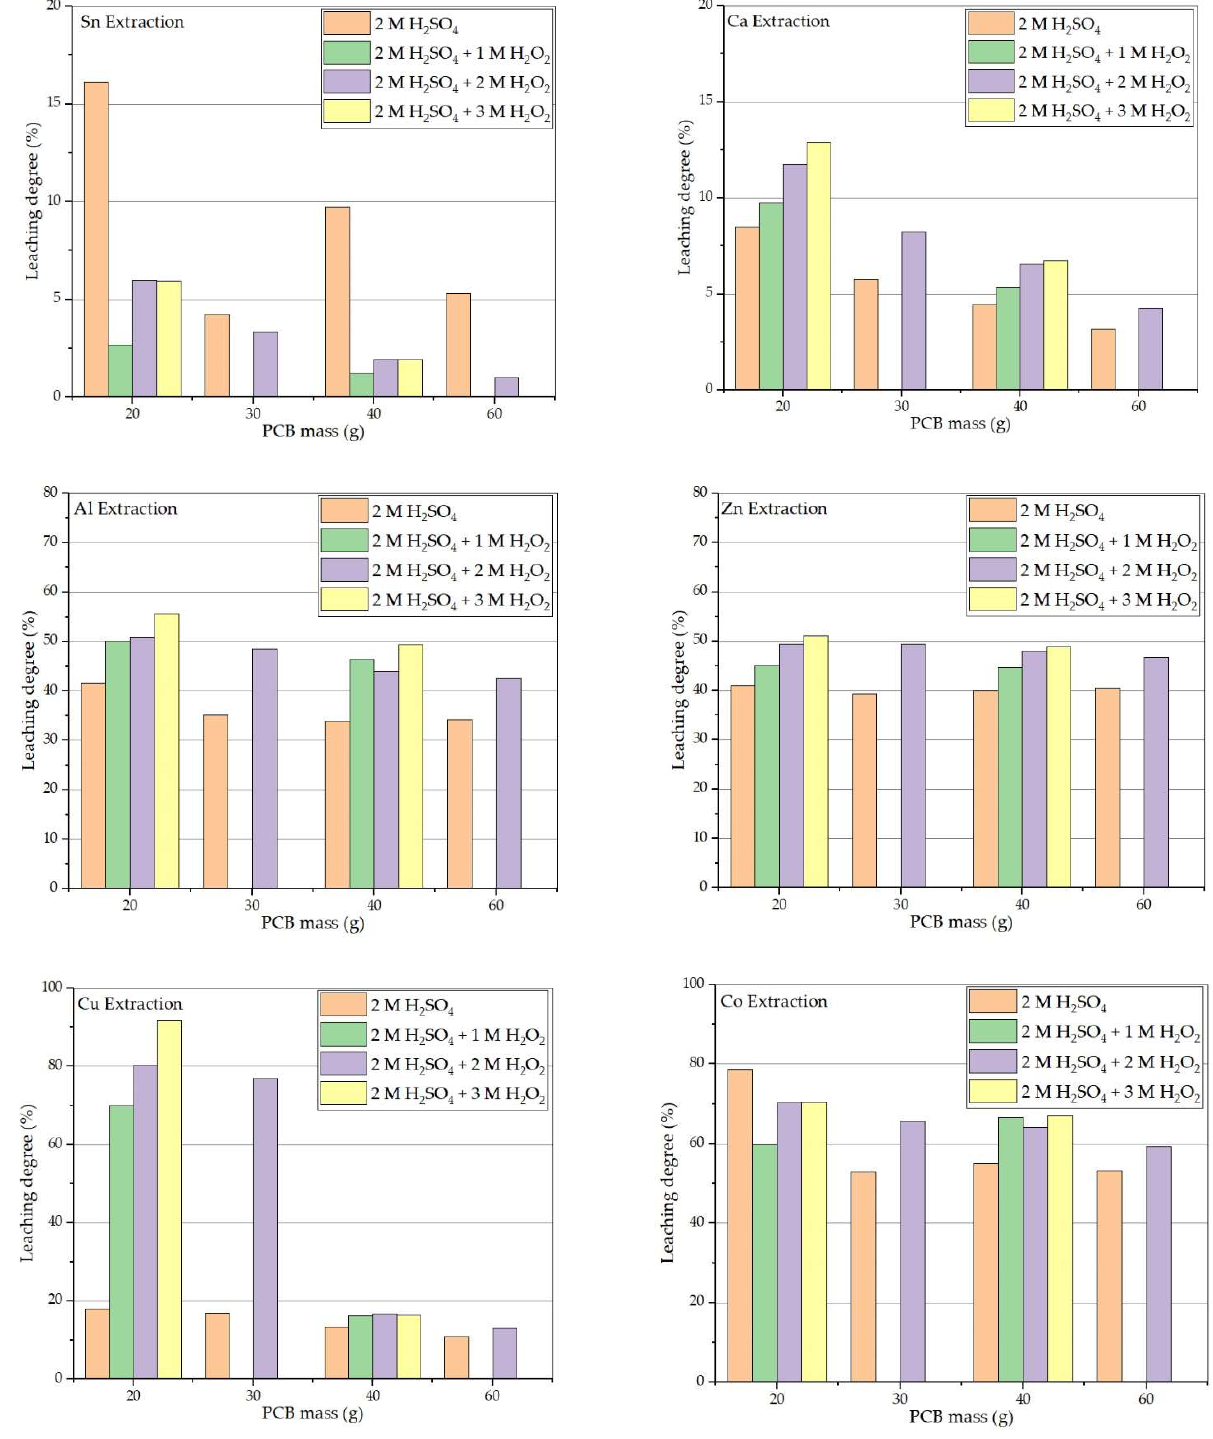
Figure 7. Element extraction after 4 h leaching in 200 mL 2 M sulfuric acid with additions of different concentrations of hydrogen peroxide (1 M 23.46 mL), (2 M 46.92 mL), and (3 M 70.38 mL) for four starting amounts of fine PPCB powders.